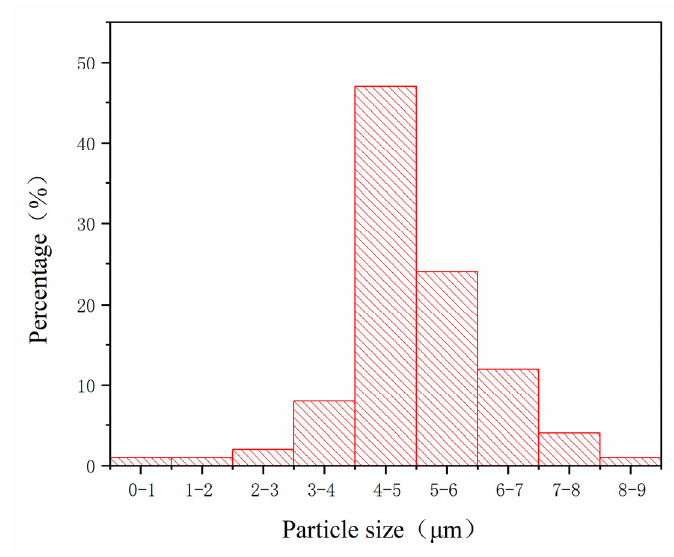
Figure 4. Particle size distribution diagram.